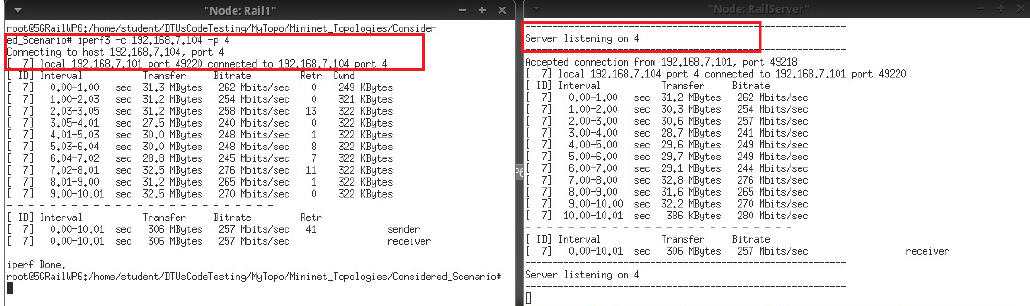
Figure 25. TCP data transmission from Train1 to RailServer.